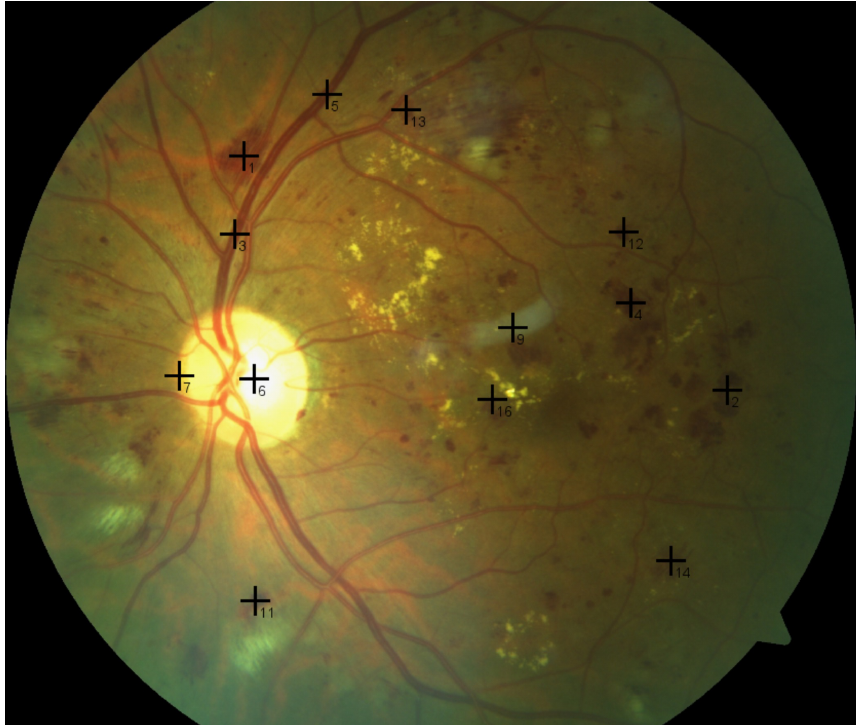
Figure 1. The subtle and tiny intensity variations in the fundus image are too difficult to identify by the naked eye, and this is where the proposed CAD system can